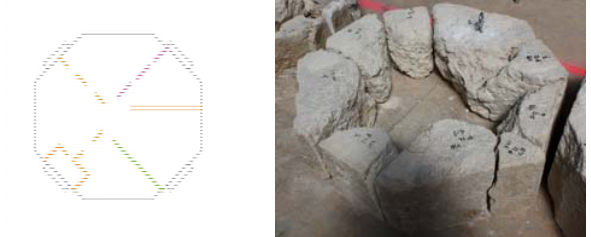
Figure 12. Pillar n. 12 – row VIII. On the left, diagnostic drawing; on the right, the ashlars disassemble and reassemble.